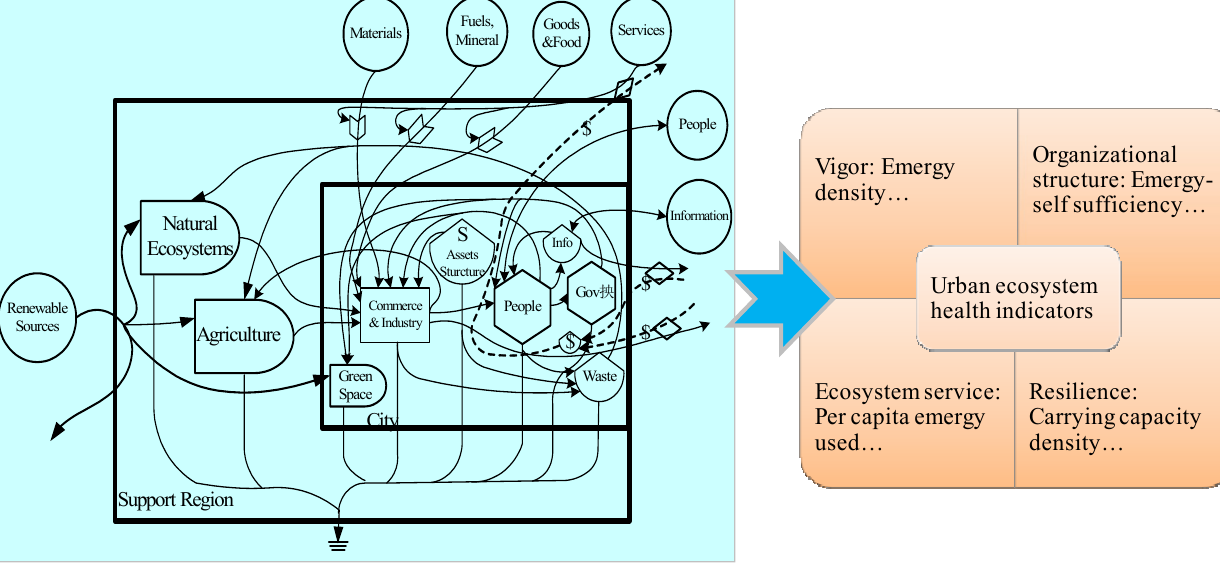
(3) Each method plays a different role in the holistic system. Methods based on urban metabolism processes are regarded as the core of the whole system. They fully reflect the internal interaction among various factors and the holistic operation of urban ecosystems. The vitality index model focusing on external performance of urban ecosystems is an important supplement for the internal analysis. Set pair analysis aims at improving the objectivity of health standards and assessment results, which should be combined with other